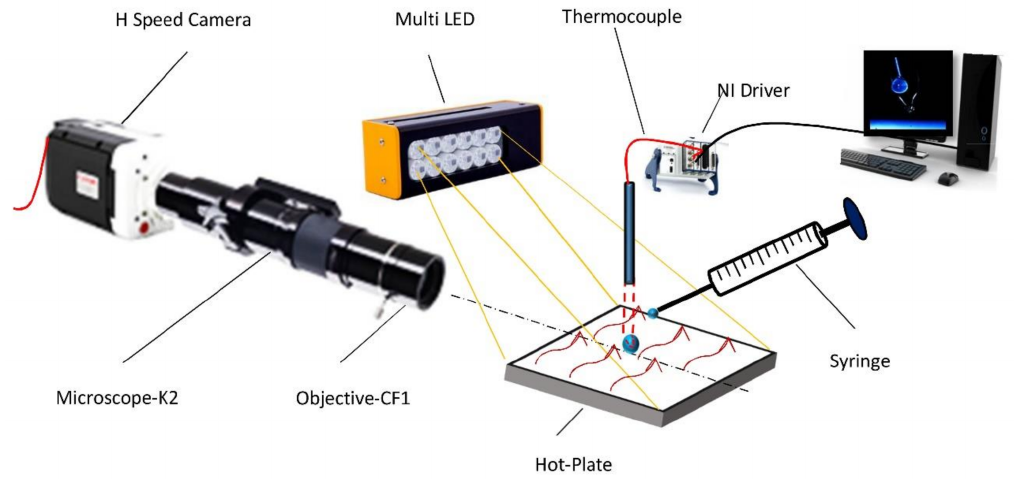
Figure 3. Experimental setup for the visualization